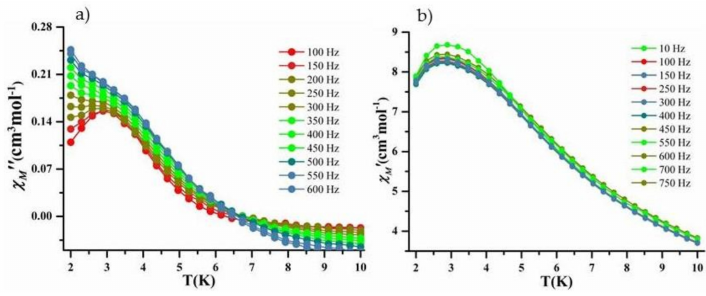
Figure 5. ( a ) Out of phase ( χ M (cid:48)(cid:48) vs. T) and, ( b ) in phase ( χ M (cid:48) vs. T) AC plot for complex 1 at 2000 Oe dc field.